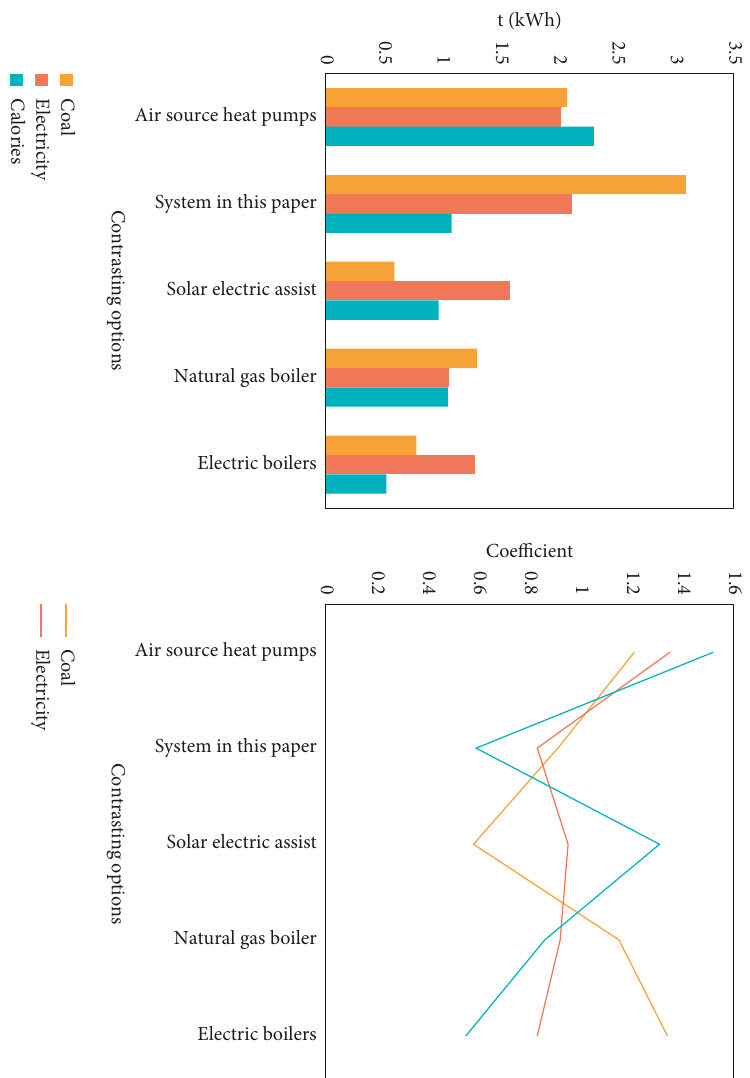
Figure 4: Energy substitution of different preparation